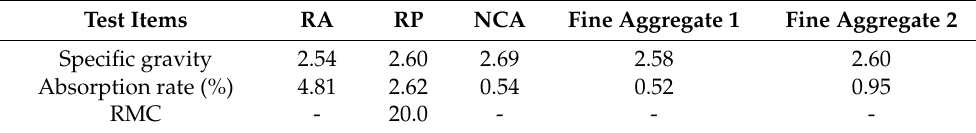
Table 1. Basic aggregate properties.